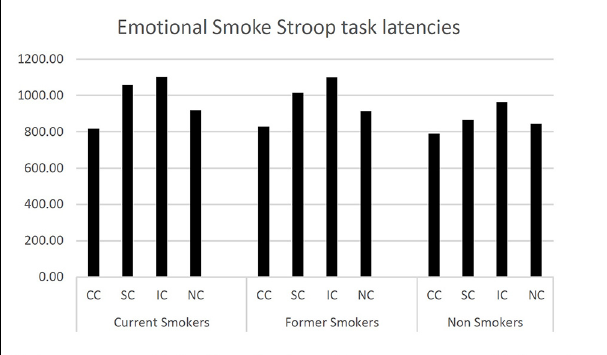
FIGURE 1 | Latency mean values of each group at the Emotional Smoke Stroop Task.